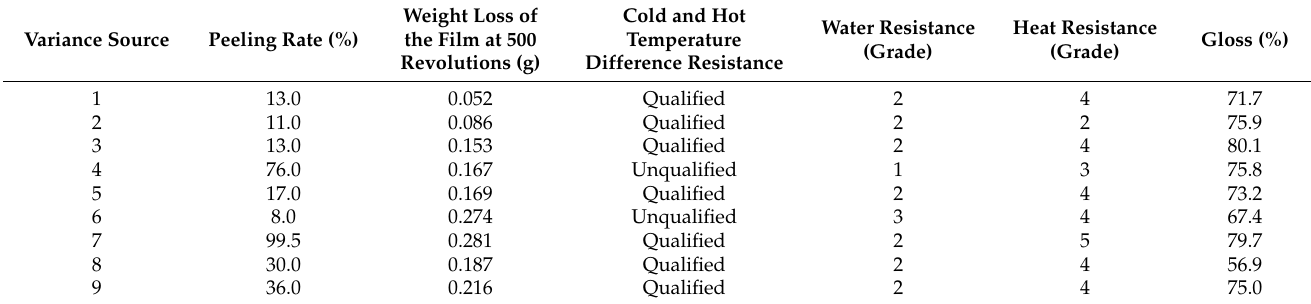
Table 7. Physical and chemical properties of different coating